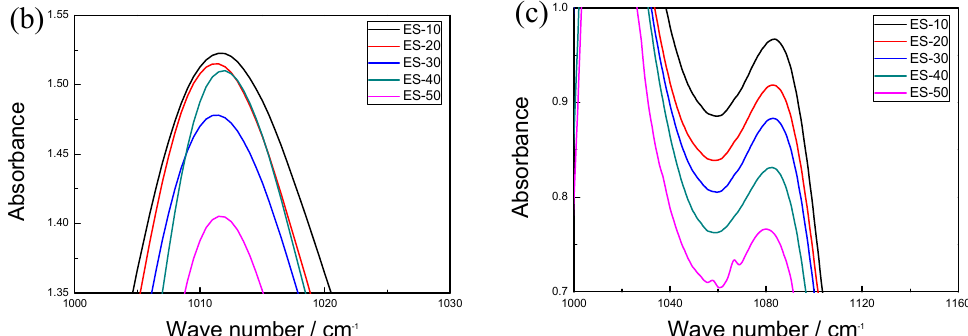
Figure 5. FTIR spectra of ( a ) epoxy modified silicone coatings; ( b ) the symmetrical stretching vibration absorption peak of Si–O–Si bond at 1010 cm − 1 ; ( c ) the anti-symmetrical vibrational absorption peak of Si–O–Si bond at 1068cm − 1 .